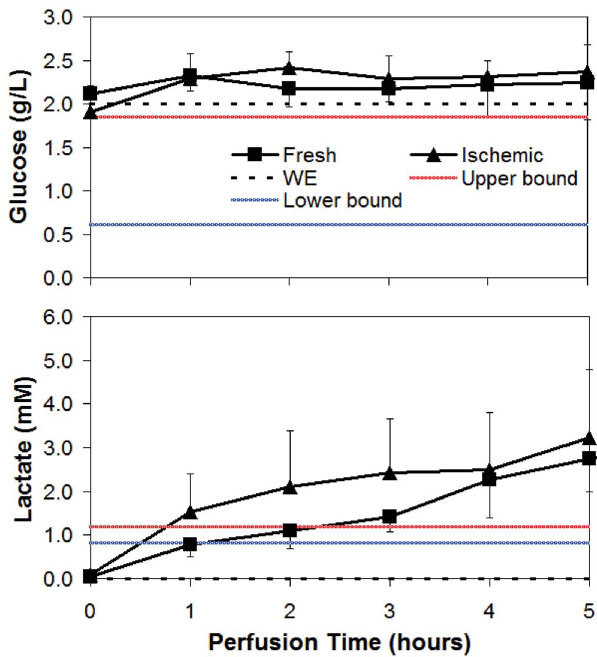
Figure 2. Average glucose and lactate concentrations during NELP of WI and Fresh livers. Dotted line is Williams Medium E (WE), red line is in vivo upper bound (ave + 1 std dev) and blue is in vivo lower bound (ave – 1 std dev).